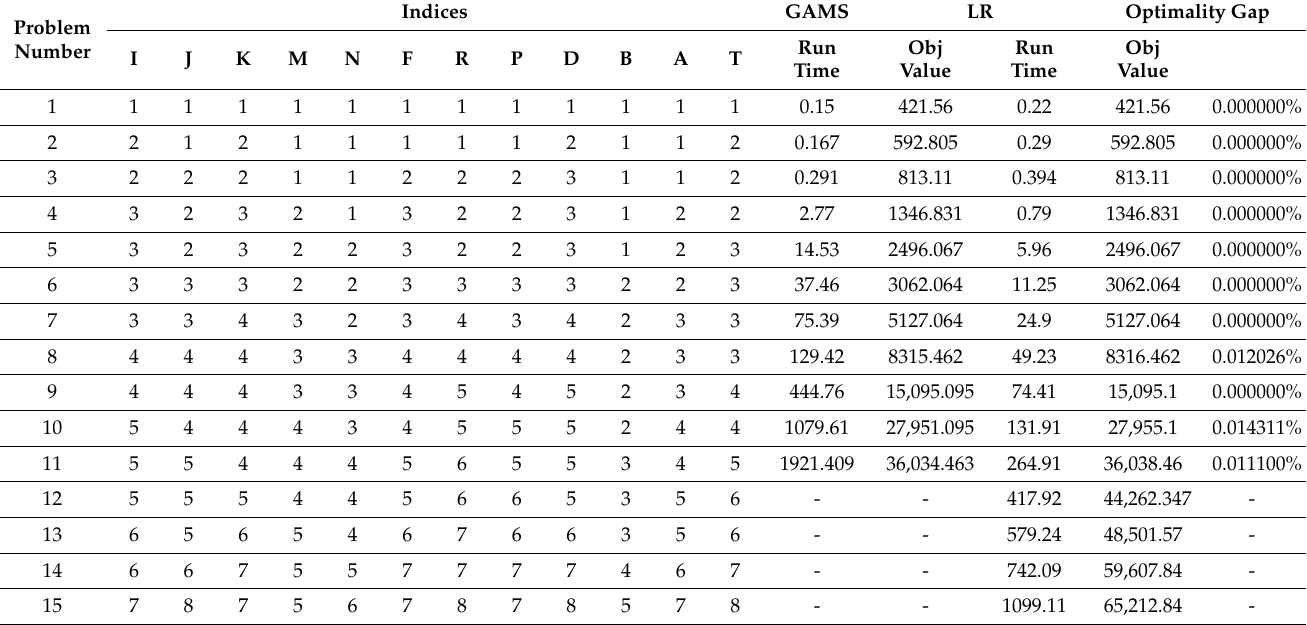
Table 5. Results of the developed epsilon-constraint method and Lagrangian relaxation.